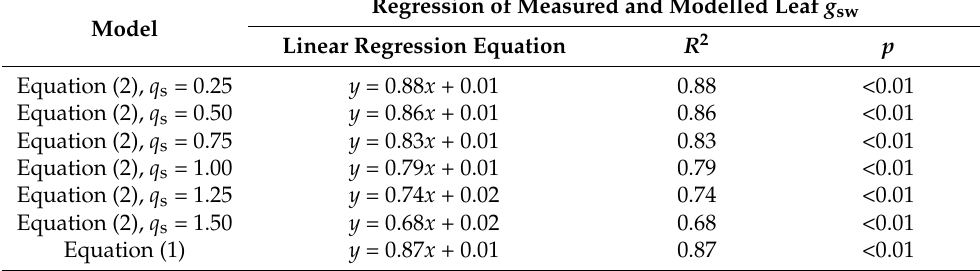
Table 1. Correlation analysis between measured and modeled leaf stomatal conductance ( g